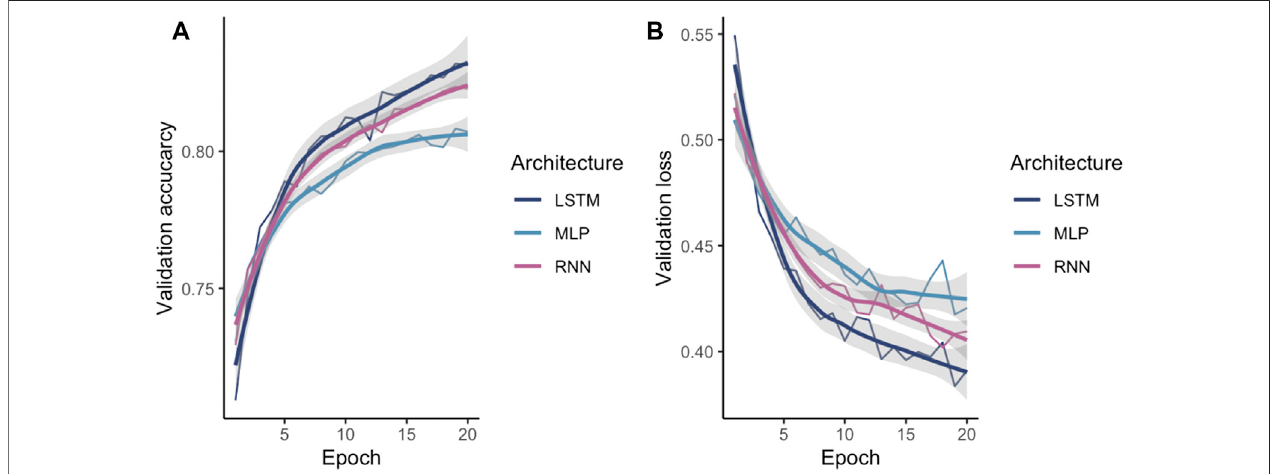
FIGURE 4 | Comparison of the validated NN models (A) accuracy and (B) loss. The X-axis shows the number of epochs while the Y-axis shows the validation accuracy or the validation loss respectively.